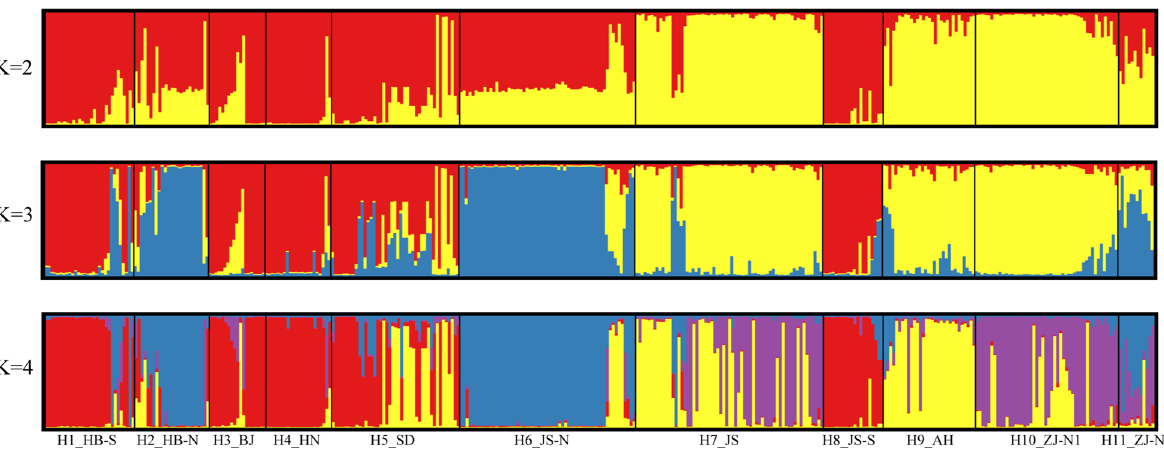
Fig.1 The division of 11 populations based on different K values (from K red, blue, and yellow, representing Cluster 1, Cluster 2, and Cluster 3, respectively. 11 populations are distributed in order from south to north. Single samples are represented by vertical bars, and the colors and proportions of color indicate that samples originated from different clusters. Populations are separated by black vertical lines